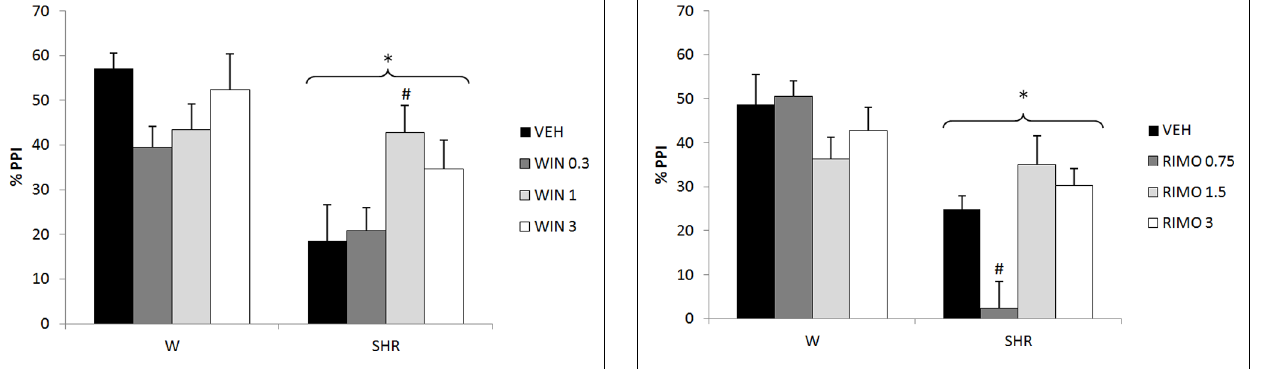
FIGURE 1 | %PPI ofWistar rats (WRs) and spontaneously hypertensive rats (SHRs) treated with vehicle (VEH), 0.3, 1, or 3 mg/kgWIN55212,2 (WIN). * p < 0.001 compared toWRs. # p < 0.05 compared toVEH group of the same strain.Three-way repeated measures ANOVA followed by Dunnett’s test. Data are reported as mean ± SE.